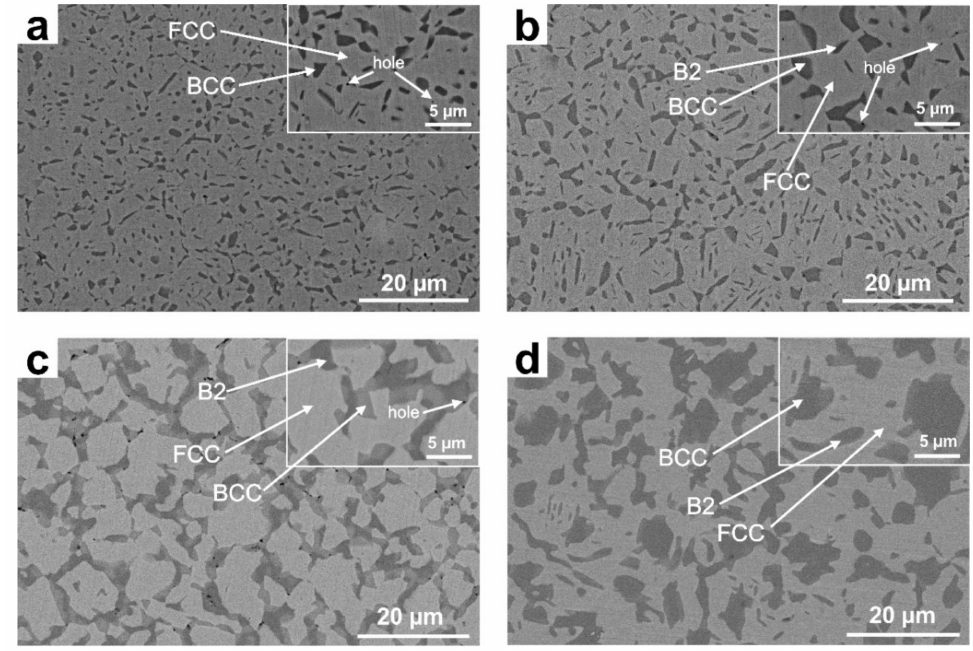
Figure 3. SEM images of Al 0.5 CoCrFeNi HEA as-sintered and treated with different cooling rates: ( a ) SS; ( b ) FC; ( c ) AC; ( d ) WQ.